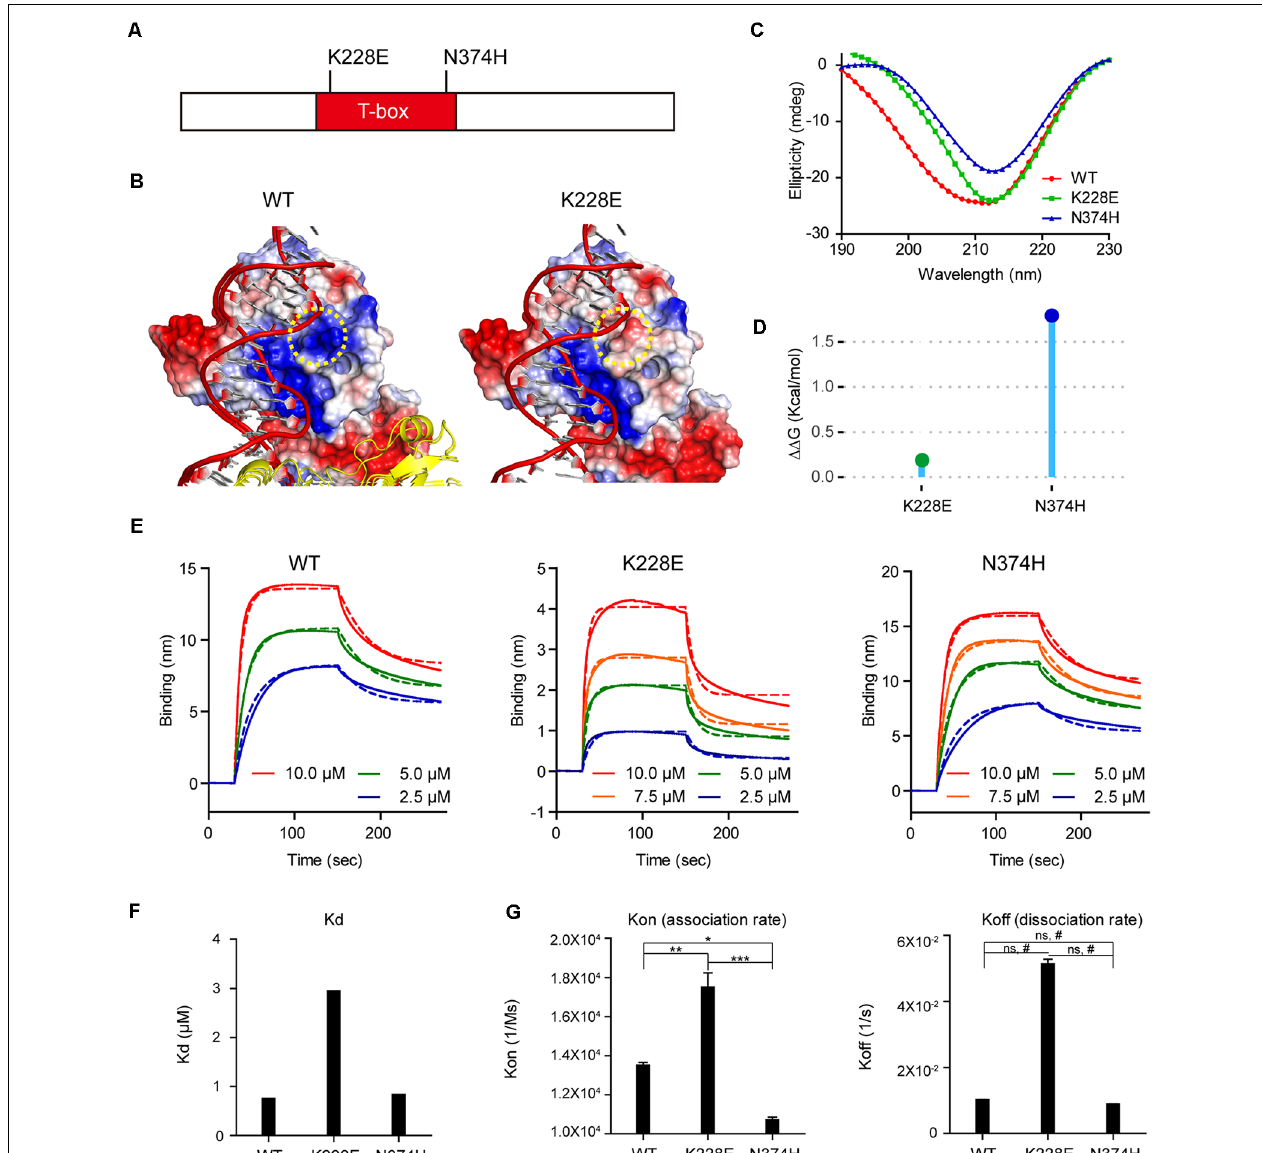
FIGURE 1 | Molecular modeling and measurement of structural stability and DNA-binding affinity of the TBR1-K228E protein. (A) Diagram depicting the location of K228E and N374H mutations in the T-box domain of the TBR1 protein. (B) Molecular modeling of the TBR1-K228E protein based on the known structure of a complex of the TBR1 T-box domain with DNA. The indicated TBR1-K228E mutation, which converts a positively charged lysine residue (blue) to a negatively charged glutamate residue (red) in a region very close to the phosphodiester backbone of the DNA, likely induces repulsion between the protein and DNA. (C) Circular dichroism (CD) profiles of purified TBR1 T-box proteins (WT, K228E, and N374H). Note that the strong negative peaks at ∼ 210 nm indicate that the secondary structures of TBR1 T-box proteins (WT, K228E, and N374H) are largely conserved. (D) Prediction of the stability of TBR1 T-box domains (WT, K228E, and N374H) by energy-minimization calculations. Note that both K228E and N374H mutations increase structural stability. (E–G) Binding analysis of WT and mutant (K228E and N374H) TBR1 T-box proteins to the Grin2b -promoter probe using biolayer interferometry (BLI). The biotinylated Grin2b -promoter probe was immobilized on a streptavidin sensor chip, and TBR1 T-box proteins were applied in the mobile phase. The dotted lines, representing fits of the raw data (solid lines), were used to obtain K d , K on , and K off values. Note the decreased DNA binding by the TBR1-K228E protein, but not the TBR1-N374H protein, compared with WT-TBR1 protein, as indicated by K d and K on/off values. n = 3 for WT, K228E, and N274H, ∗ P < 0.05, ∗∗ P < 0.01, ∗∗∗ P < 0.001, ns, not significant, one-way analysis of variance (ANOVA) with Tukey’s test, # P < 0.05, Student’s t